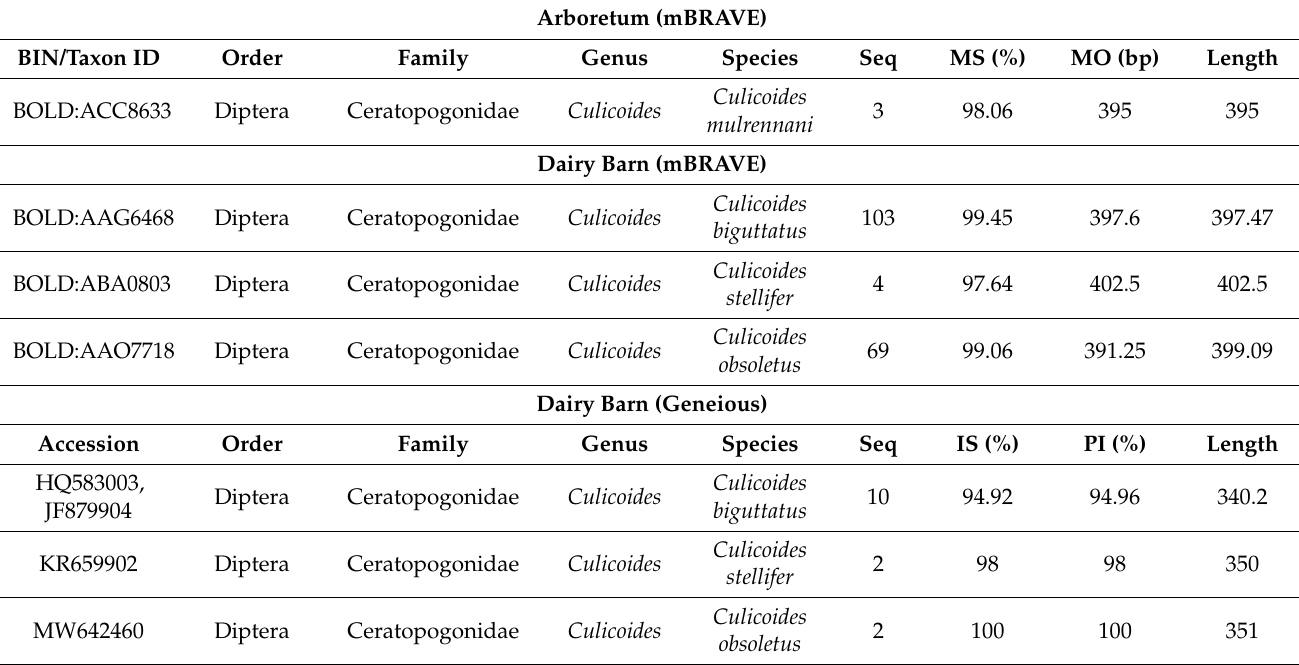
Table 3. Culicoides spp. identified per trap using the reference library for BINs found in the BOLD database (mBRAVE) and GeneBank database (Geneious). Included are the reference library’s BIN taxon identifier (BIN.Taxon.ID)/GenBank accession number (Accession), the taxonomic rankings of the species in the reference library (Order, Family, Genus, Species), the number of corresponding DNA sequences (Seq), average percent mean similarity (MS (%)), mean overlap (MO (bp)), percentage of identical sites (IS (%)), percentage of pairwise identity (PI (%)), and average bp length analyzed